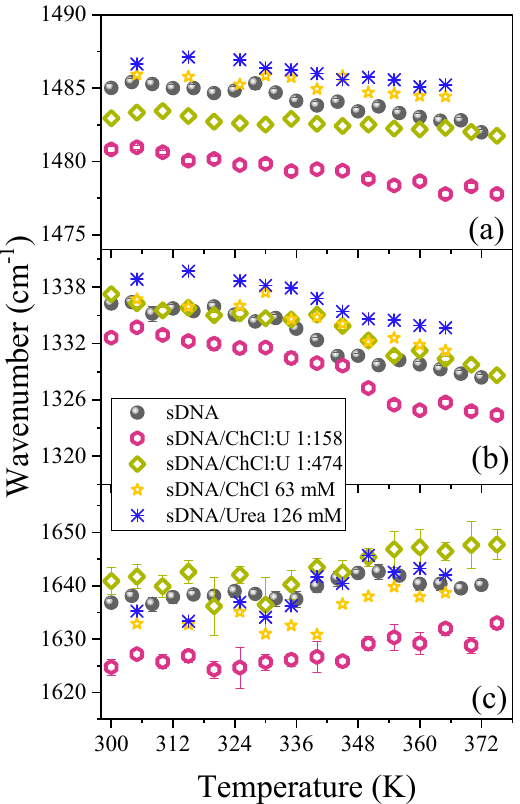
Figure 4. Temperature evolution of the central wavenumber position of the Raman bands ( a ) dGI, ( b ) dA + dG, and ( c ) dT for sDNA in the absence and presence of ChCl:U (1:158 and 1:474 ratio of molar concentrations) and sDNA in hydrated in ChCl (63 mM in Tris) and in hydrated urea (126 mM in Tris).